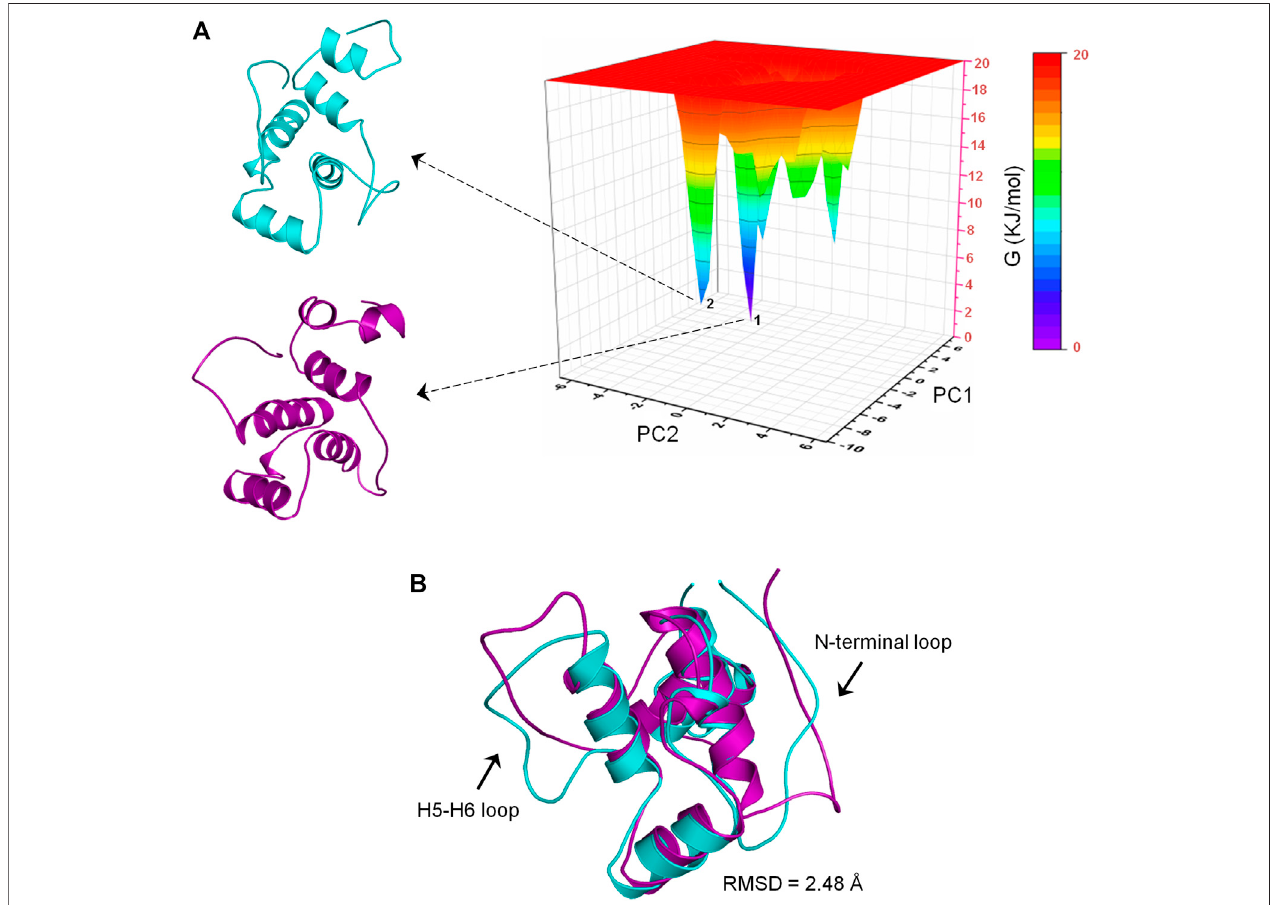
FIGURE7| Freeenergylandscape(FEL)analysisfortheCbtAmodel. (A) FELdiagramforCbtAshowingstructuresextractedfromthemainminima.Thestructures are extracted from the tips of the wells which represent the most stable conformations. (B) Superimposed structures from minima 1 and 2 revealing the main structural variations. Structures from minima 1 and 2 are colored purple and cyan,